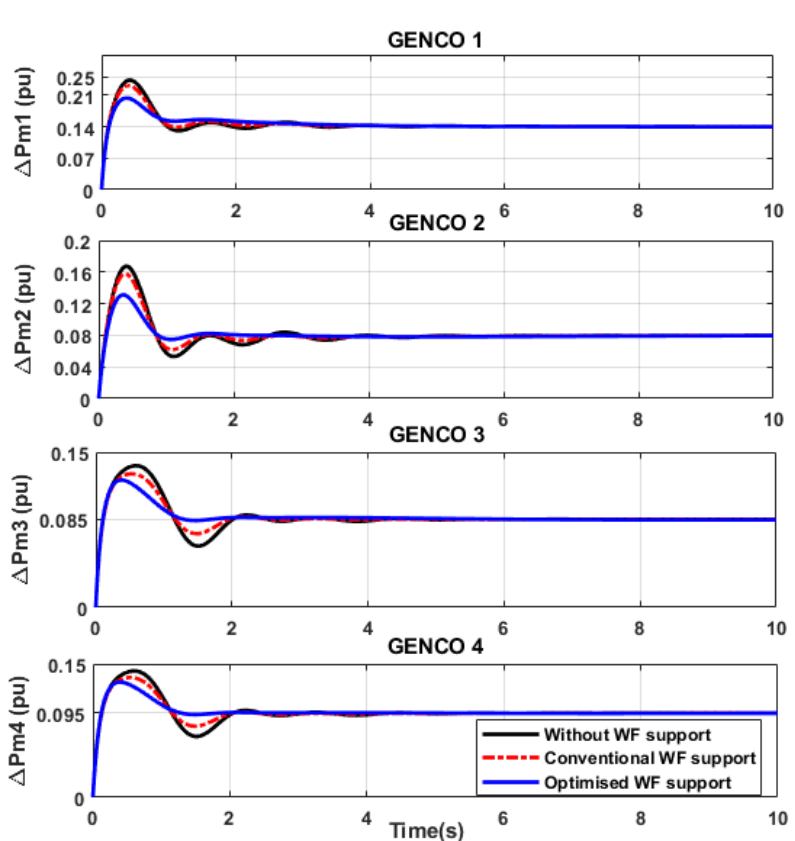
Figure 15. Change in power generation of GENCOs in bilateral transaction.